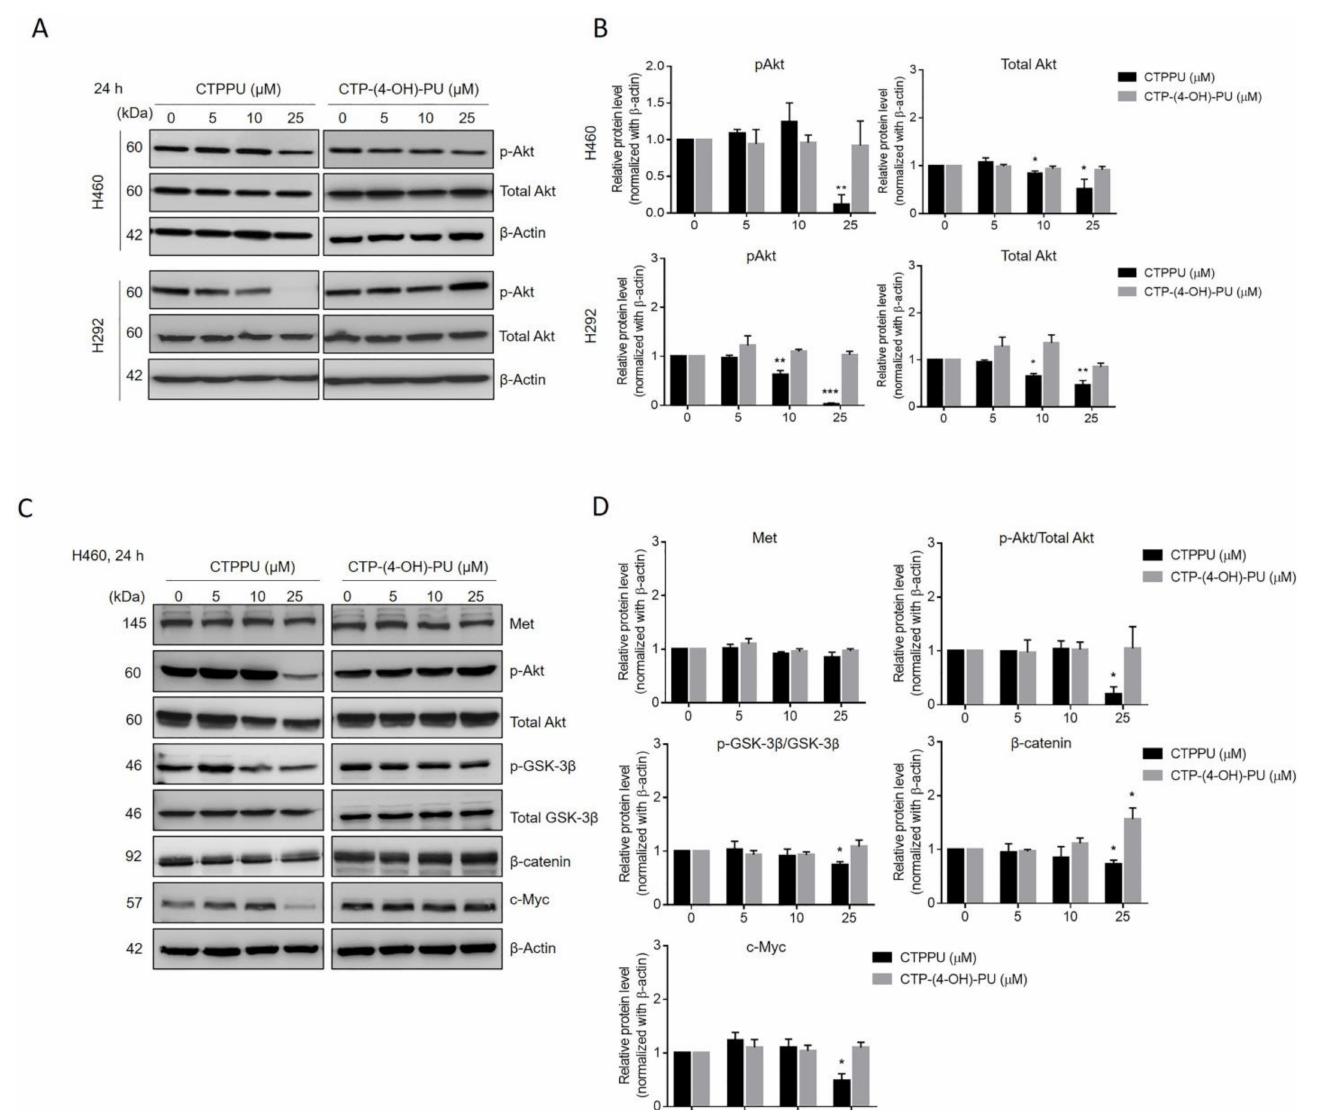
Figure 5. Effect of phenyl urea derivatives (CTPPU and CTP(4-OH)-PU) on Akt/GSK-3 β /c-Myc signaling pathway. ( A ) The expression levels of phosphorylated (p) and total Akt in H460 and H292 cells were assessed by Western blot analysis after 24 h of urea derivatives treatment. ( B ) Bar graphs showed the quantitative results of ( A ). ( C ) The expression of Met, p-Akt, total Akt, p-GSK-3 β , total GSK-3 β , β -catenin, and c-Myc in H460 were determined by Western blotting after being treated with phenyl urea derivatives. β -Actin was used as an internal control. ( D ) Bar graphs showed the quantitative results of C. The data are shown as the mean ± SD of three independent experiments (* p < 0.05, ** p < 0.01, and *** p < 0.001 compared with the